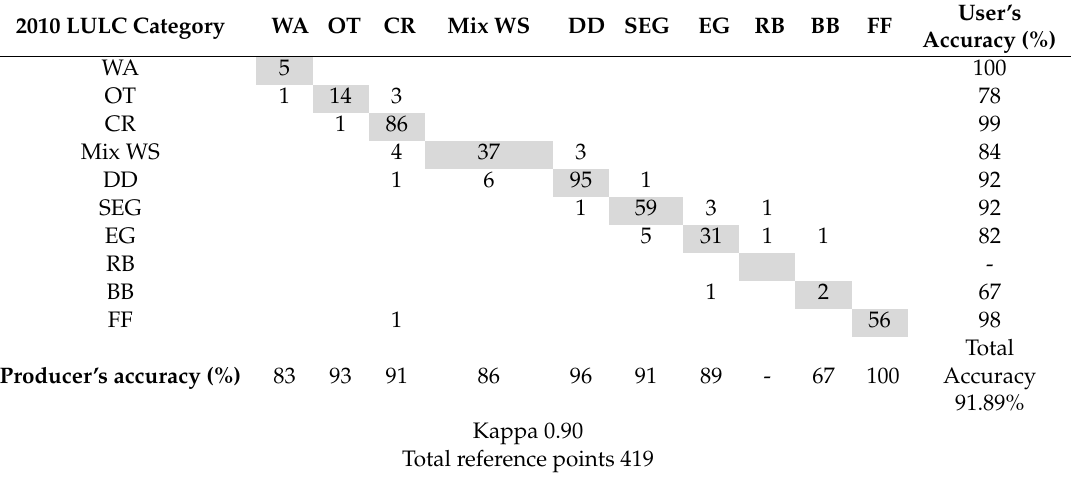
Table A5. Results of the accuracy assessment of the PBTC land cover map for